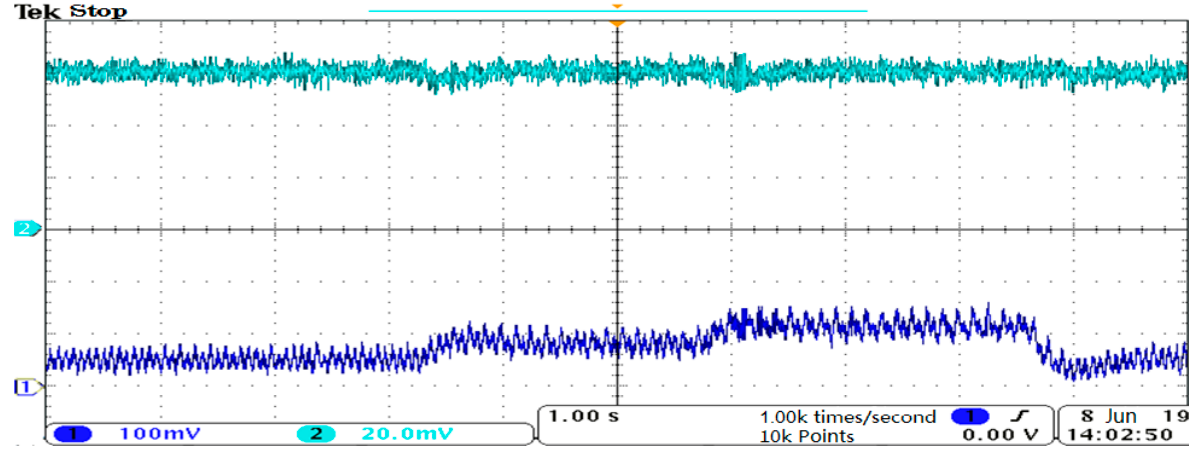
Figure 17. Dynamic load addition and load reduction process of EESM at low switching frequency, CH1: speed waveform; CH2: torque